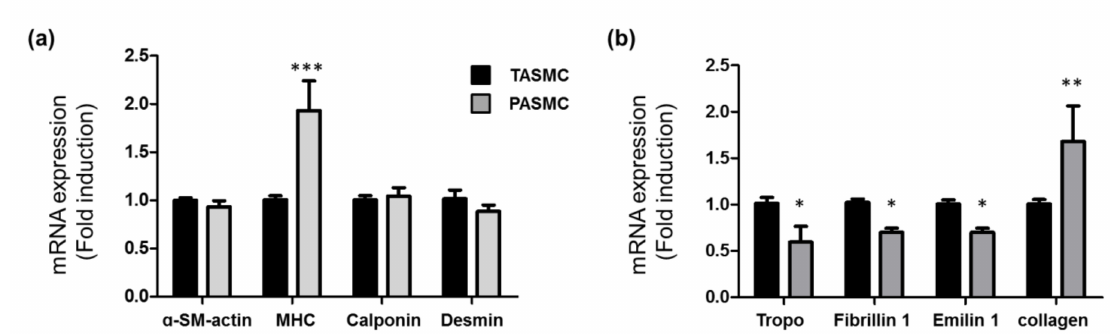
Figure 2. The SMC markers and ECM gene expression profiles of SMC. Representative qRT-PCR analysis. ( a ) The mRNA expression levels of SMC marker gene profiles. ( b ) ECM gene expression profiles. The expression di ff erences were compared with GAPDH as a loading control. The SMCs were harvested for RNA at passage 1. Data are shown as the mean ± SEM in the same group of four individual SMCs isolated from either TASMCs or PASMCs. The black bars represent the TASMCs. The gray bars represent the PASMCs. * p < 0.05, ** p < 0.01, *** p < 0.001 compared with the